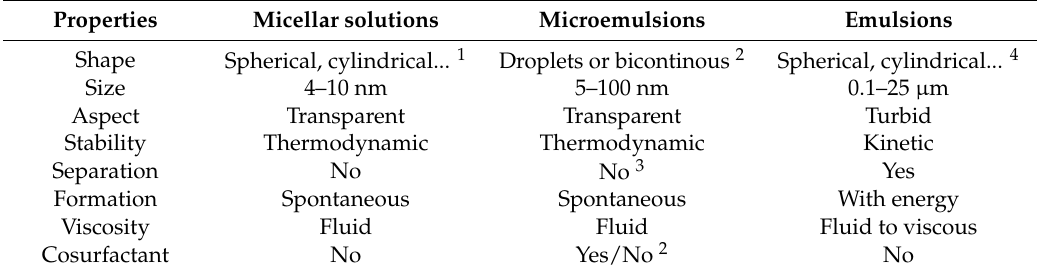
Table 1. The principal difference between micellar solutions, emulsions, and